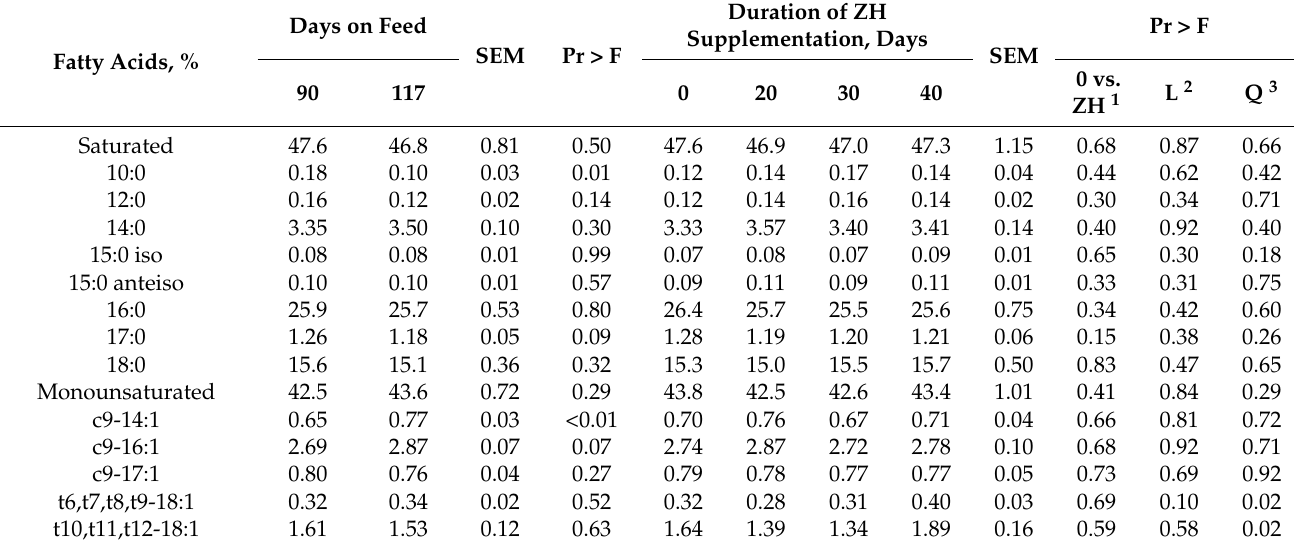
Table 3. Least square means, standard error of the mean (SEM), and probabilities (Pr > F) of fatty acid composition (%) of meat samples according to the duration of zilpaterol hydrochloride (ZH) supplementation and days on feed.